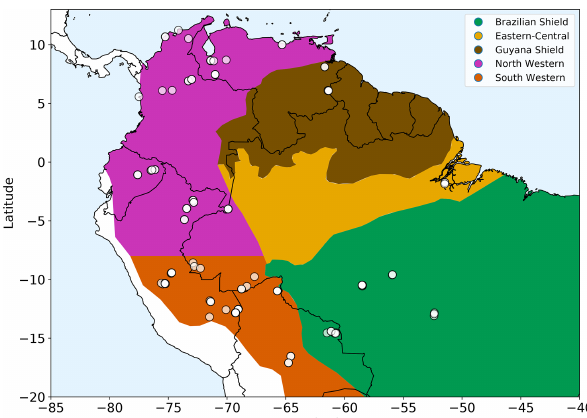
Figure 1. Amazonian allometric regions. Each region, shown by the coloured areas, is defined by geography, rainfall and soil substrate. White circles show location of the forest plots used. The two west- ern regions share common allometry but are split based on rainfall seasonality for analysis